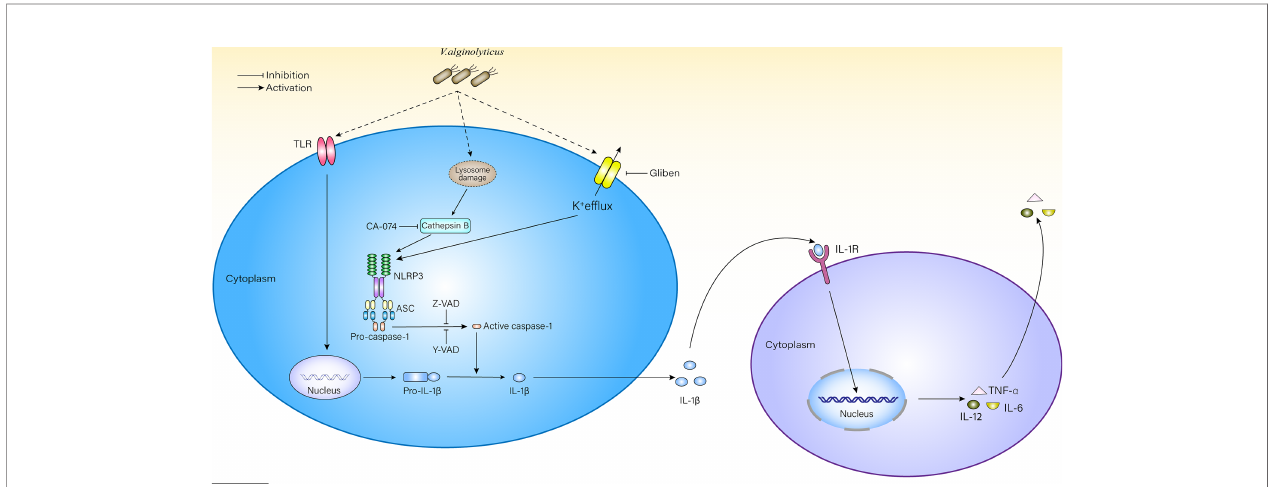
FIGURE 6 | Schematic diagram of mechanisms underlying V. alginolyticus -induced in fl ammatory response. V. alginolyticus triggering in fl ammatory response by recognizing extracellular TLRs and intracellular NLRP3. NLRP3 in fl ammasome was activated by potassium ion out fl ow and lysosomal disruption to release cathepsin B, mediated IL-1 b release, and controlled cytokine secretion. This process could be completely reversed by Z-VAD-FMK or partially reversed by Ac-YVAD-CHO, glyburide, and CA-074 methyl